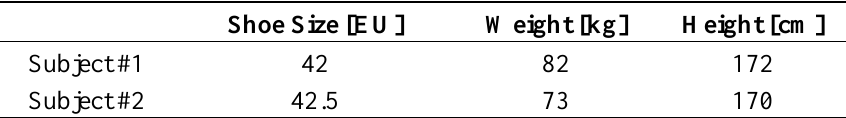
Table 2. Subjects